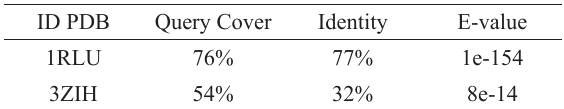
Information about the Blast. Alignment between Corynenacterium sequences and Crystal structure from